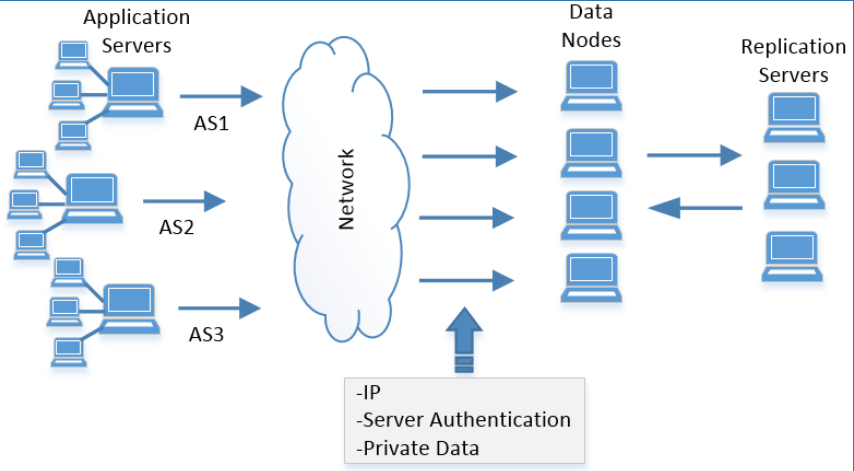
Figure 2. System overall structure.